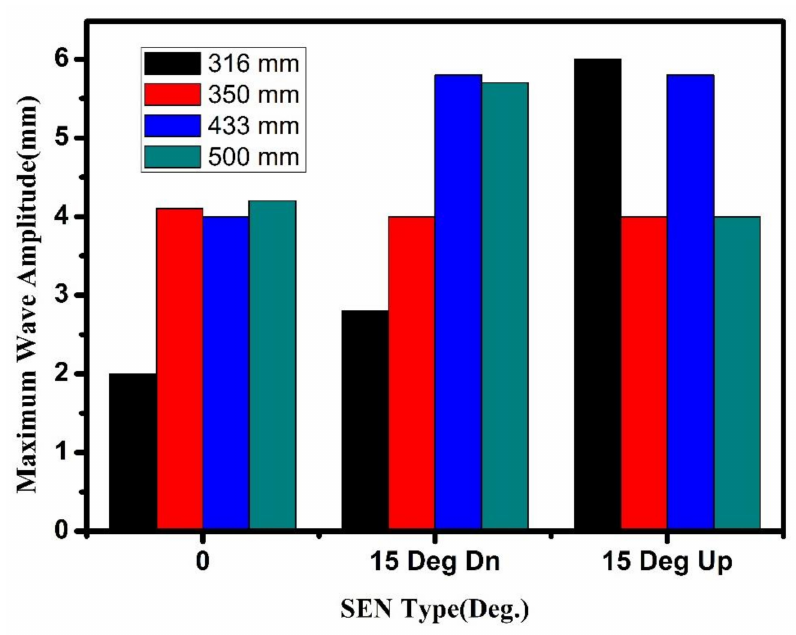
Figure 10. Variation of maximum surface wave amplitude with different nozzle types at 40 L/min liquid flow rate from Submerged Entry Nozzle (SEN) at different mould width.